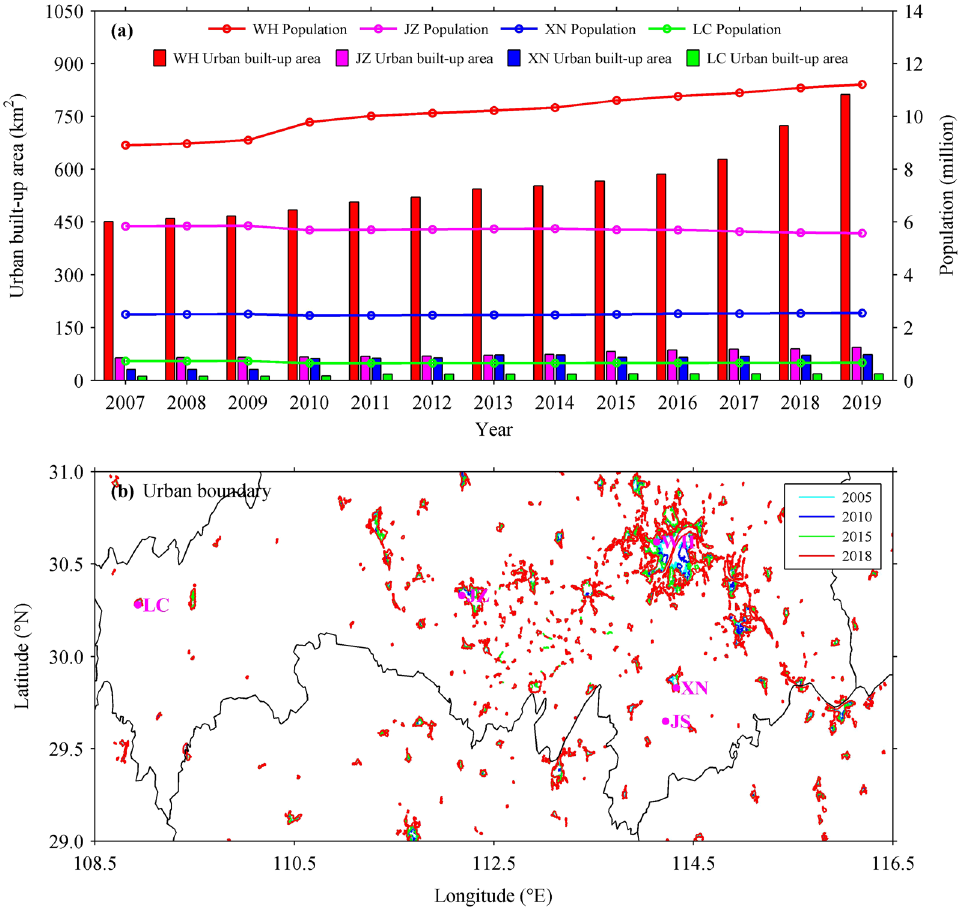
Figure 2. ( a ) Interannual variations of the population and urban built-up area in WH, JZ, XN and LC cities during 2007–2019, and ( b ) urban boundaries in study region during 2005–2018 obtained from the satellite- based land use category maps (http:// data. ess. tsing hua. edu.